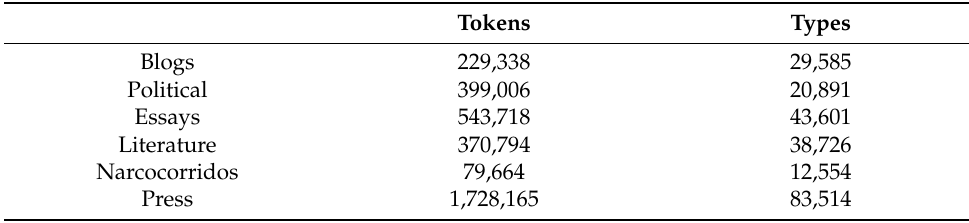
Table 1. General statistics about the corpus. Tokens Types Blogs 229,338 29,585 Political 399,006 20,891 Essays 543,718 43,601 Literature 370,794 38,726 Narcocorridos 79,664 12,554 Press 1,728,165